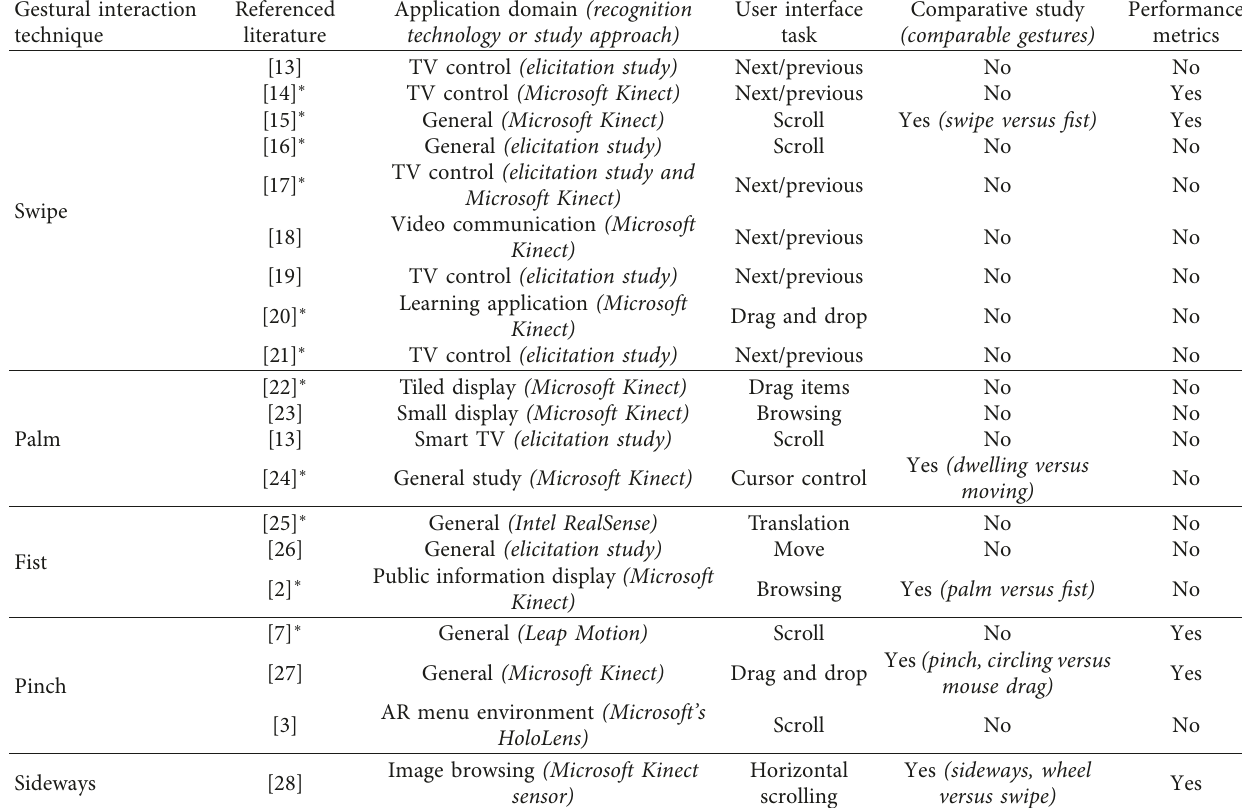
Table 1: The comparison of user studies designing interaction techniques for translation tasks. Gestural